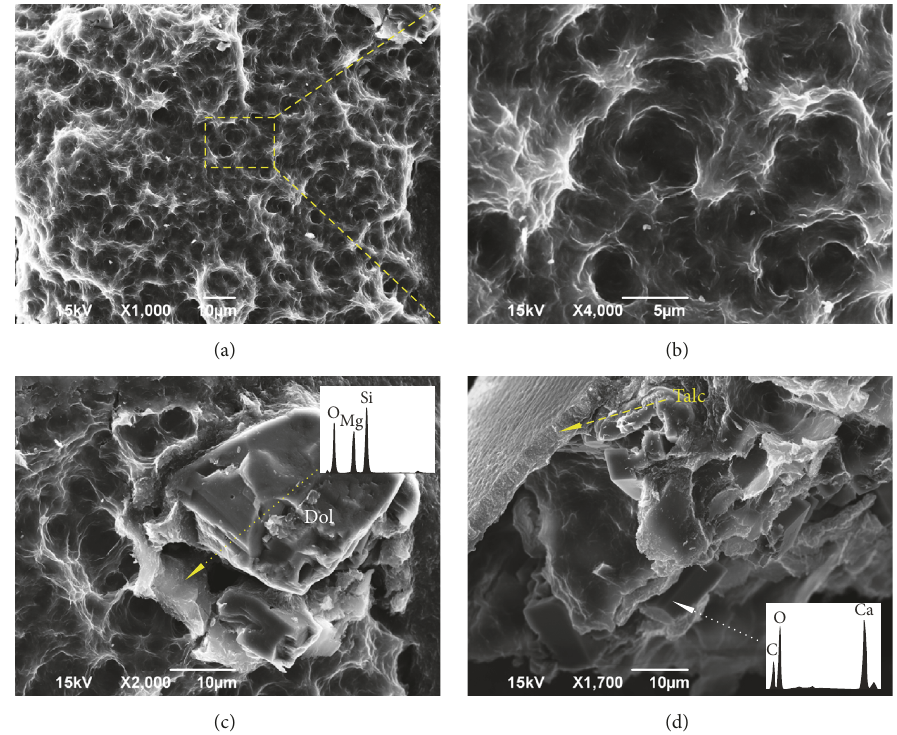
Figure 7: SEM micrographs and EDS analyses of the solid relicts in an FSCC containing dolomite and water after heating at 200 ∘ C for ∼ 60 days. (a, b) Honeycomb-like talc; (c) dolomite grains with smooth edges and EDS result of talc (yellow arrow); (d) euhedral calcite formed in the relicts (white arrow) and cylindrical talc growing on the inner surface of the tube (yellow